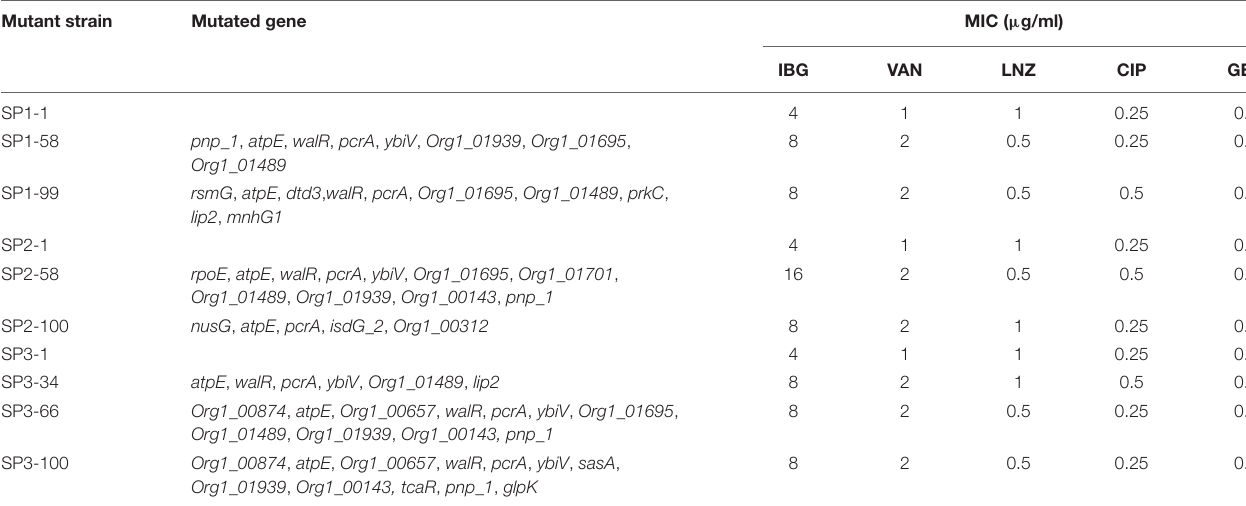
TABLE 3 | Antimicrobial susceptibility of S. aureus ATCC 29213 mutants isolated by serial passage for 100 days. Mutant strain Mutated gene